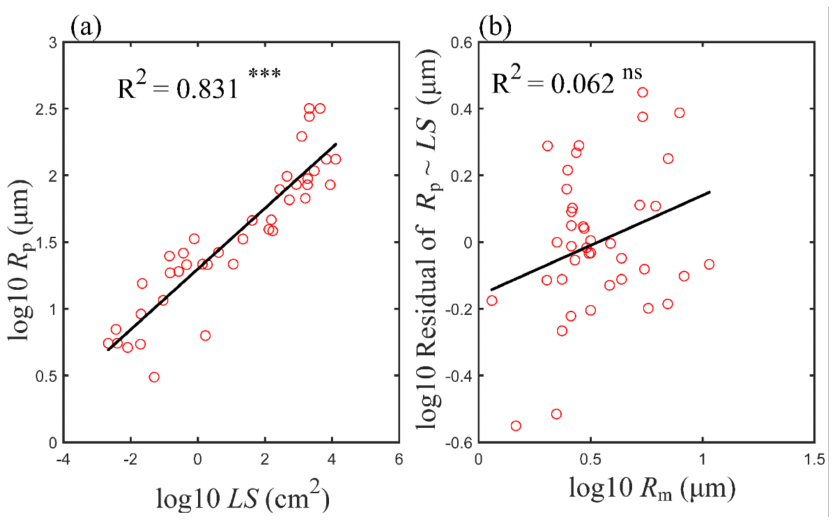
Figure 5. Log − log scaling relationship between leaf size ( LS ) and the hydraulic radius of petiole vessels, R p ( a ), and the residual variation of R p (after eliminating the contribution of LS through linear regression) vs. the hydraulic radius of minor vein vessels, R m ( b ). R 2 is indicated in each panel. Asterisks indicate levels of significance (ns, p > 0.05; *** p < 0.001). Abbreviations for traits are the same as in Table